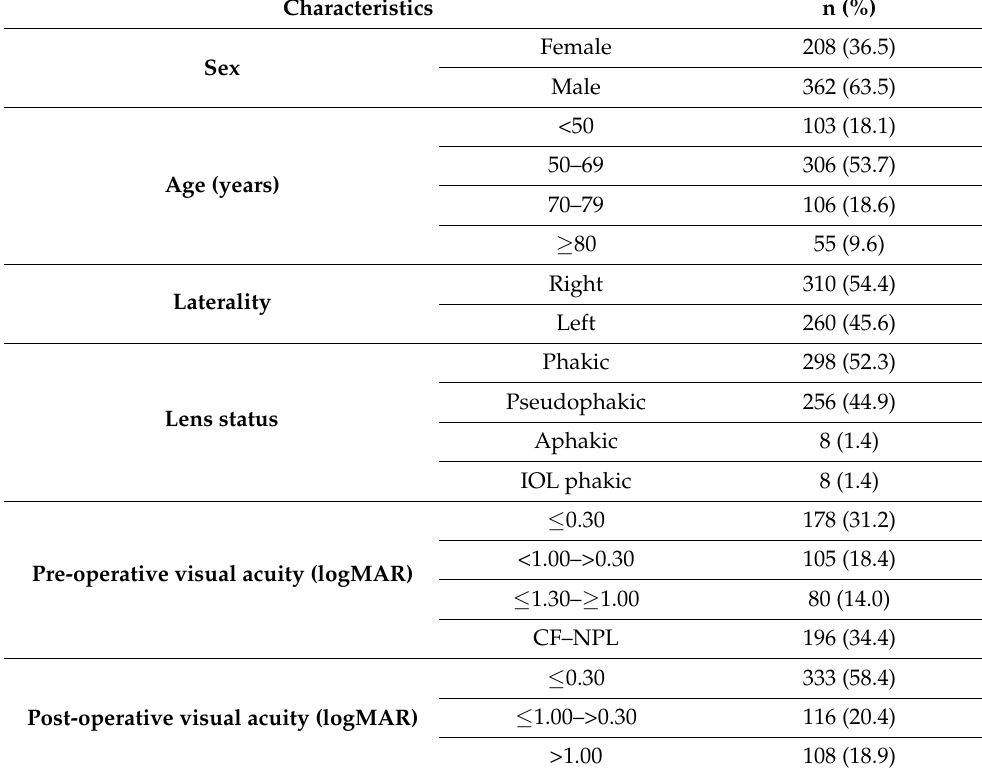
Table 2. Characteristics of the study population expressed as numbers (n) and percentages